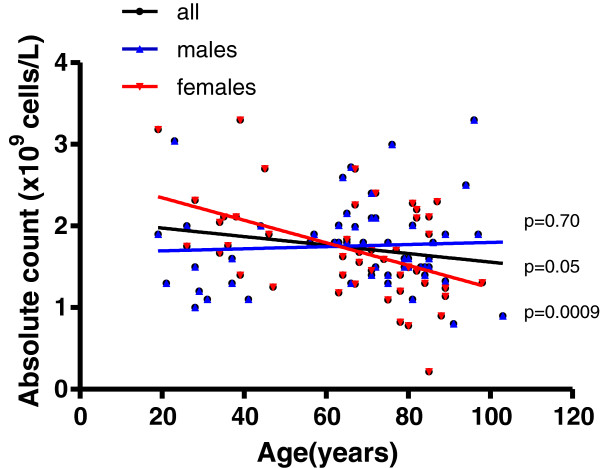
Distribution of lymphocytes counts from CMV-IgG seropositive individuals. The linear regression results for males (blue line, n=53) and female (red line, n=47), the corresponding p values are shown on the graphs nearby each regression line, p<0.05 indicates statistical differences.